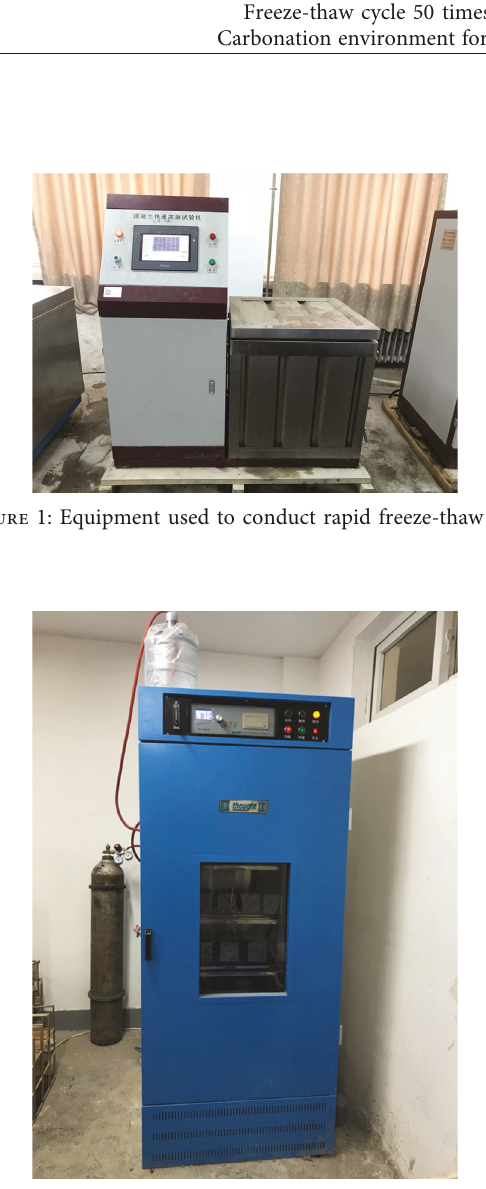
Figure 2: Rapid carbonation test